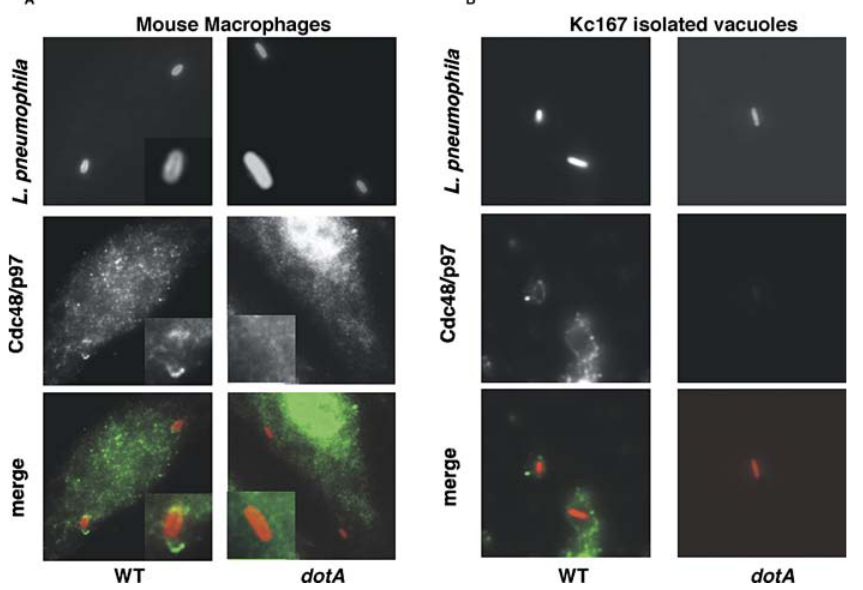
Figure 3. Cdc48/p97 Localizes to the L. pneumophila Vacuole (A) Mouse BMDMs were incubated with L. pneumophila for 1 h at MOI ¼ 1, fixed, and immunostained for human Cdc48/p97 and L. pneumophila . Inset is an enlargement of bacterium in panel. Cdc48/p97 associated with 63% 6 11% vacuoles harboring wild-type bacteria and 1.3% 6 1% dotA bacteria. (B) Kc167 cells were incubated with L. pneumophila for 1 h at MOI ¼ 1; replication vacuoles were isolated, fixed, and immunostained with antibodies against Drosophila Cdc48/p97 (Ter94) [35] and L. pneumophila . Cdc48/p97 associated with 77% 6 6.9% vacuoles harboring wild-type bacteria and